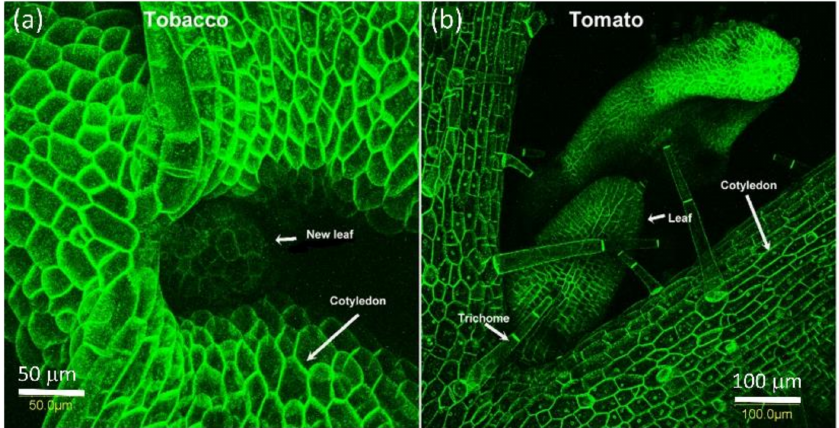
Figure 4. PDLP5-GFP is present in all surface cells of tobacco and tomato 7-day seedlings. The bar shows the distance in µ m. ( a ) Meristematic area of 7 days old tobacco seedling where the new leaf emerge between the cotyledons; ( b ) Meristematic area of 10 days old tomato seedling where the new leaves emerge between the